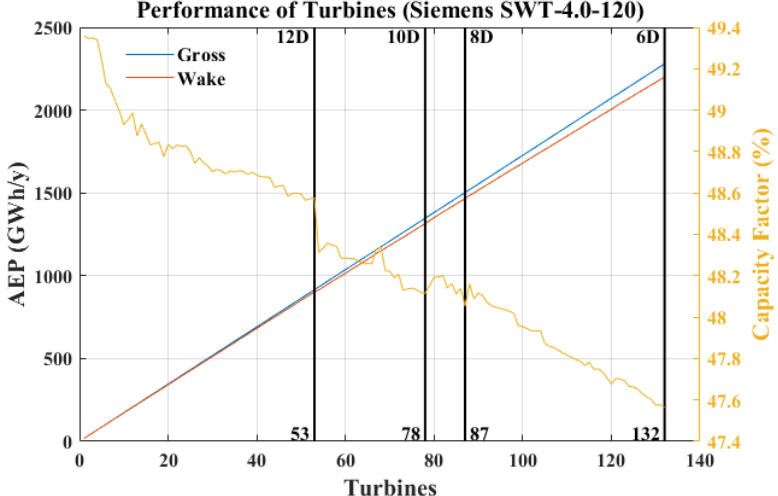
Figure 8. AEP and capacity factor with different numbers of turbines in ZoP 26 wind farm estimated using mast data.